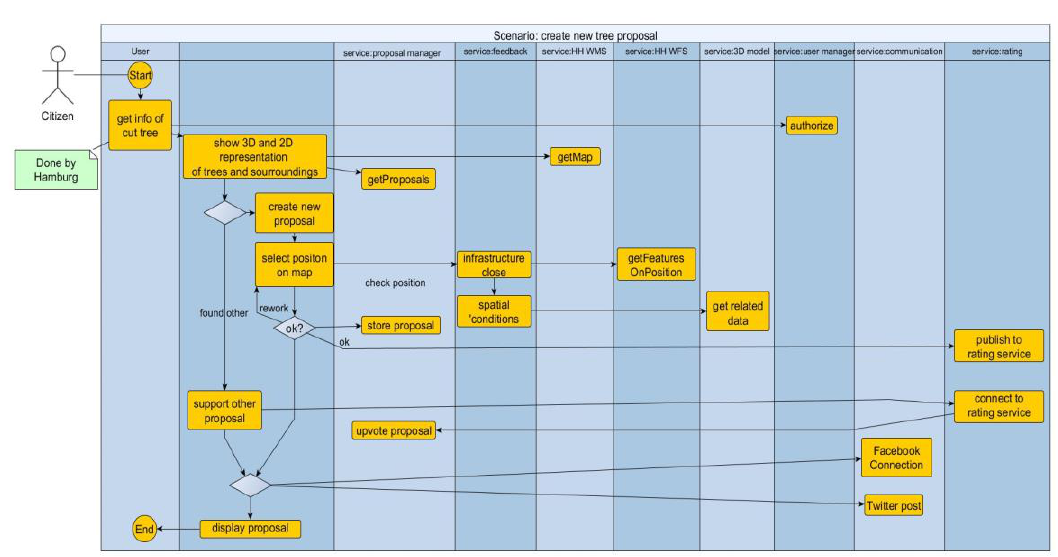
Figure 7. Example of an Activity Diagram: Hamburg: CO 2 Neutral-Tree Planning Scenario.